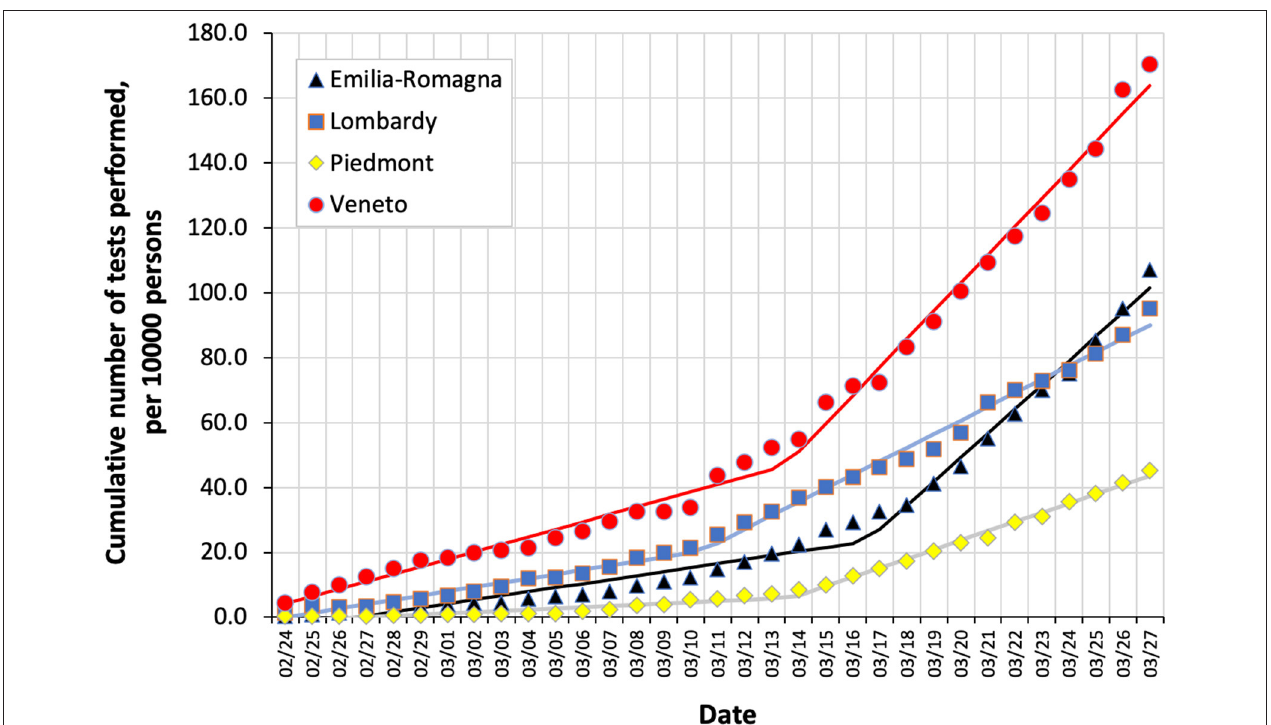
FIGURE 1 | Cumulative number of COVID-19 tests performed in four regions in northern Italy from February 24 through March 27, per 10,000 persons in each region. Piecewise regression lines are also shown.